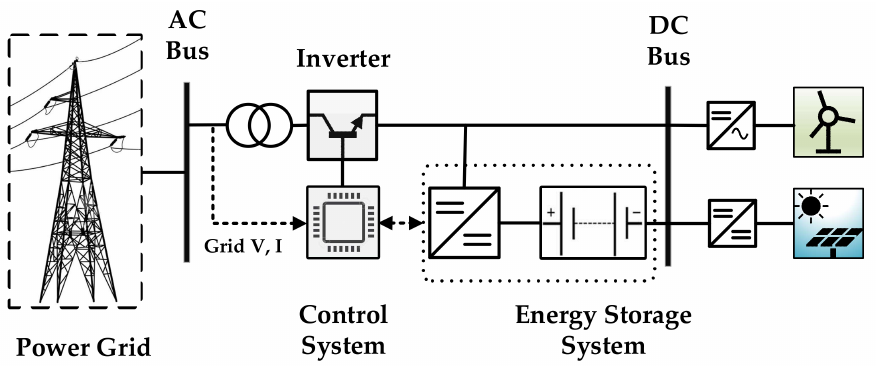
Figure 3. A typical structure of a virtual synchronous generator